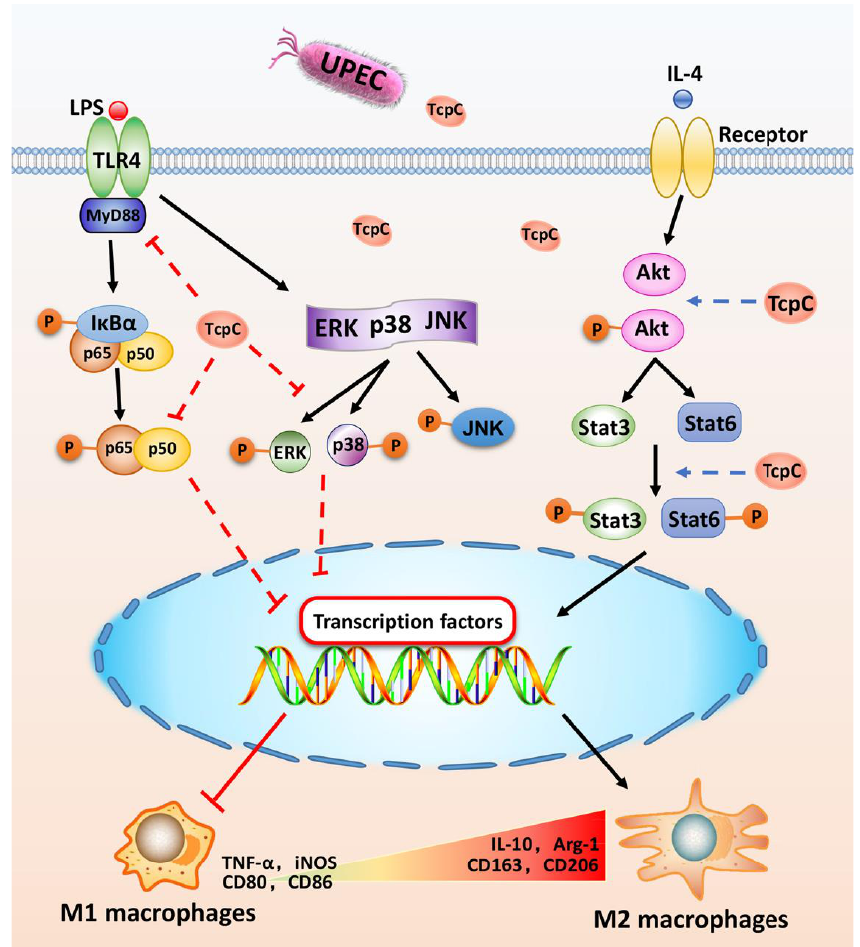
Figure 8. Schematic diagram of the molecular mechanisms by which TcpC inhibits M1 but promotes M2 polarization.